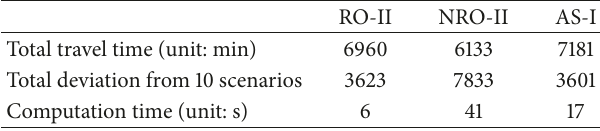
Table 8: Computational results of different contrast